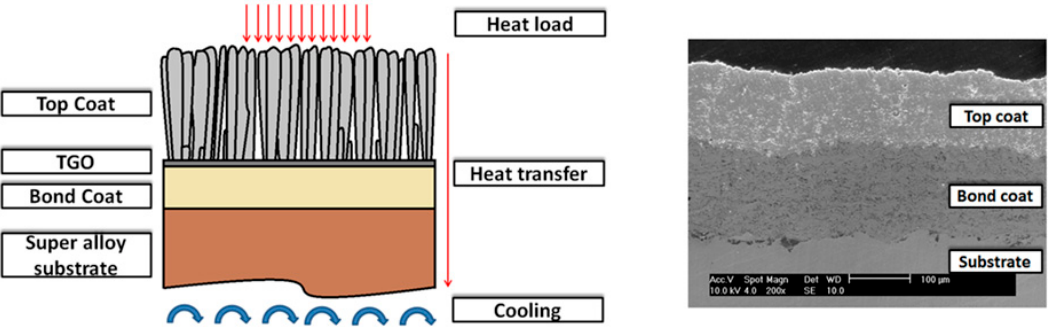
Figure 13. The schematic representation of TBC structure ( left ) and as-sprayed one ( right ) [27]. Reproduced with permission from [Advances in Materials Science Research], Nova, 2016. TBC is a very well-known FGC system. The initial studies on the functionally graded thermally sprayed TBCs were performed more in the 1970s [291,292].